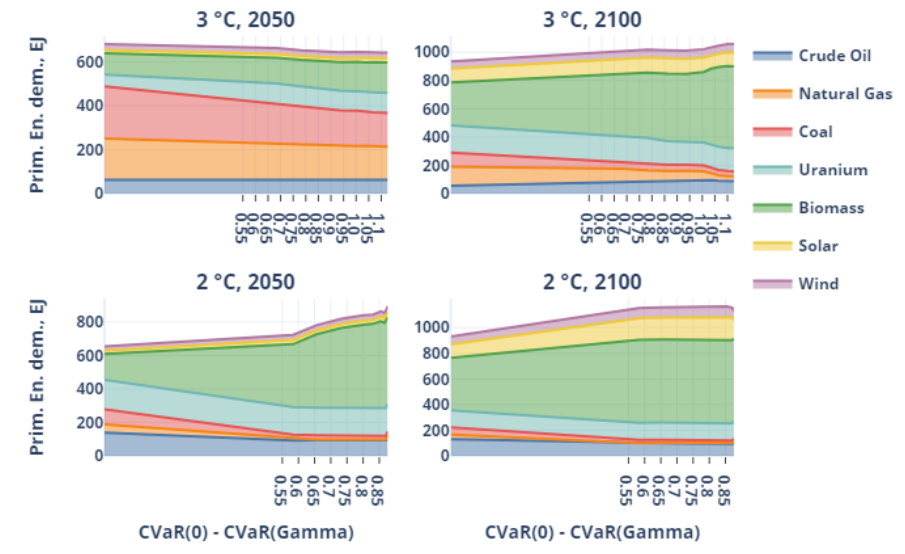
Figure 8. Primary energy consumption by type against protection level. Table 3. Primary energy consumption by